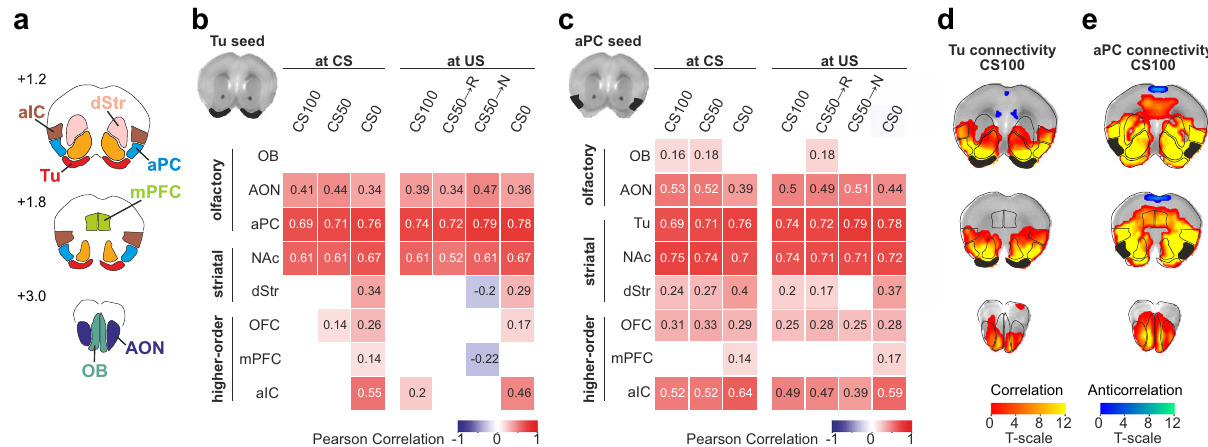
Fig. 4 Learned odor-reward associations recruit differential networks functionally connected to Tu and aPC. a Analogous to Fig. 3b. Task-based functional connectivity was examined between regions of the olfactory association-learning network (OB, AON, aPC, Tu, NAc, dStr, OFC, mPFC, and aIC). b , c Task-based functional connectivity between ( b ) Tu and the other regions for CS and US for each trial type. Pearson correlation coef fi cients between the region-wise beta-series were calculated for each session ( n = 51 across 18 animals). The group-level signi fi cance was tested using a one-sample t test on the Fisher z-transformed correlation coef fi cients ( P < 0.05, Bonferroni-corrected for multiple comparisons). Pairwise correlations that did not reach signi fi cance are indicated by empty boxes. The connectivity between Tu and higher-order regions depended on the respective CS. c Same as ( b ) showing aPC connectivity. d , e Analogous analysis as in ( b ) and ( c ), but voxel-wise. Group-level maps showing seed-based functional connectivity for CS100 in ( d ) Tu and in ( e ) aPC ( n = 51 sessions in 18 animals). Signi fi cance threshold was set to P < 0.025, FDR-corrected for two-sided testing. Red color spectrum indicates a positive correlation, while blue color indicates anti-correlation. Seed regions marked in black. A composite mask of all ROIs listed in ( a ) was used for this analysis. See Supplementary Fig. 5a, b for the complete analysis performed on different task